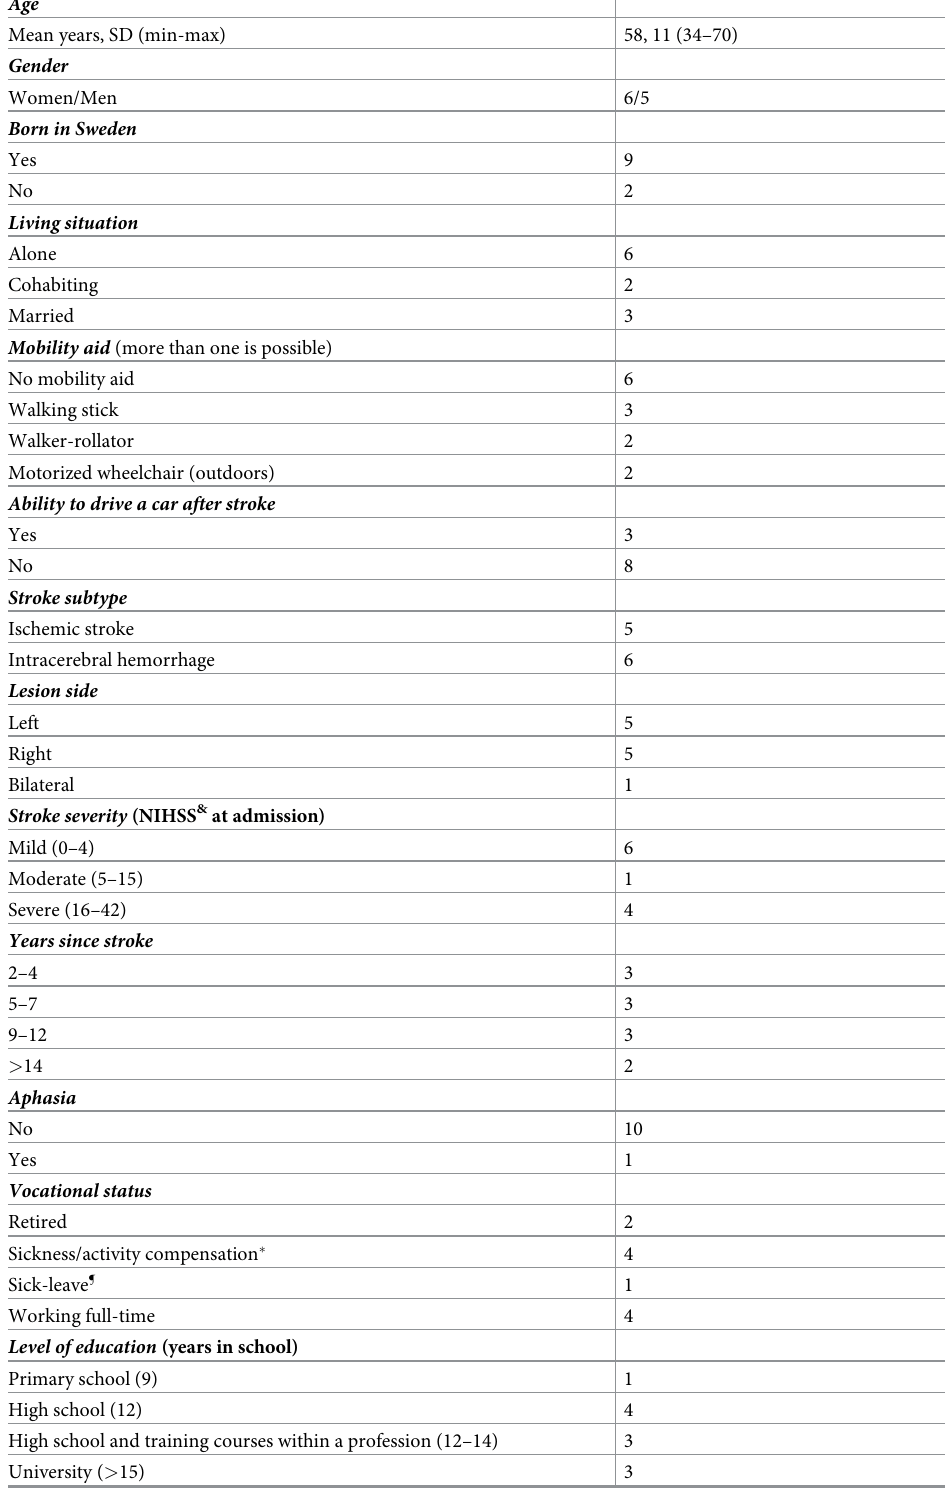
Table 1. Characteristics and clinical assessment of study participants, n